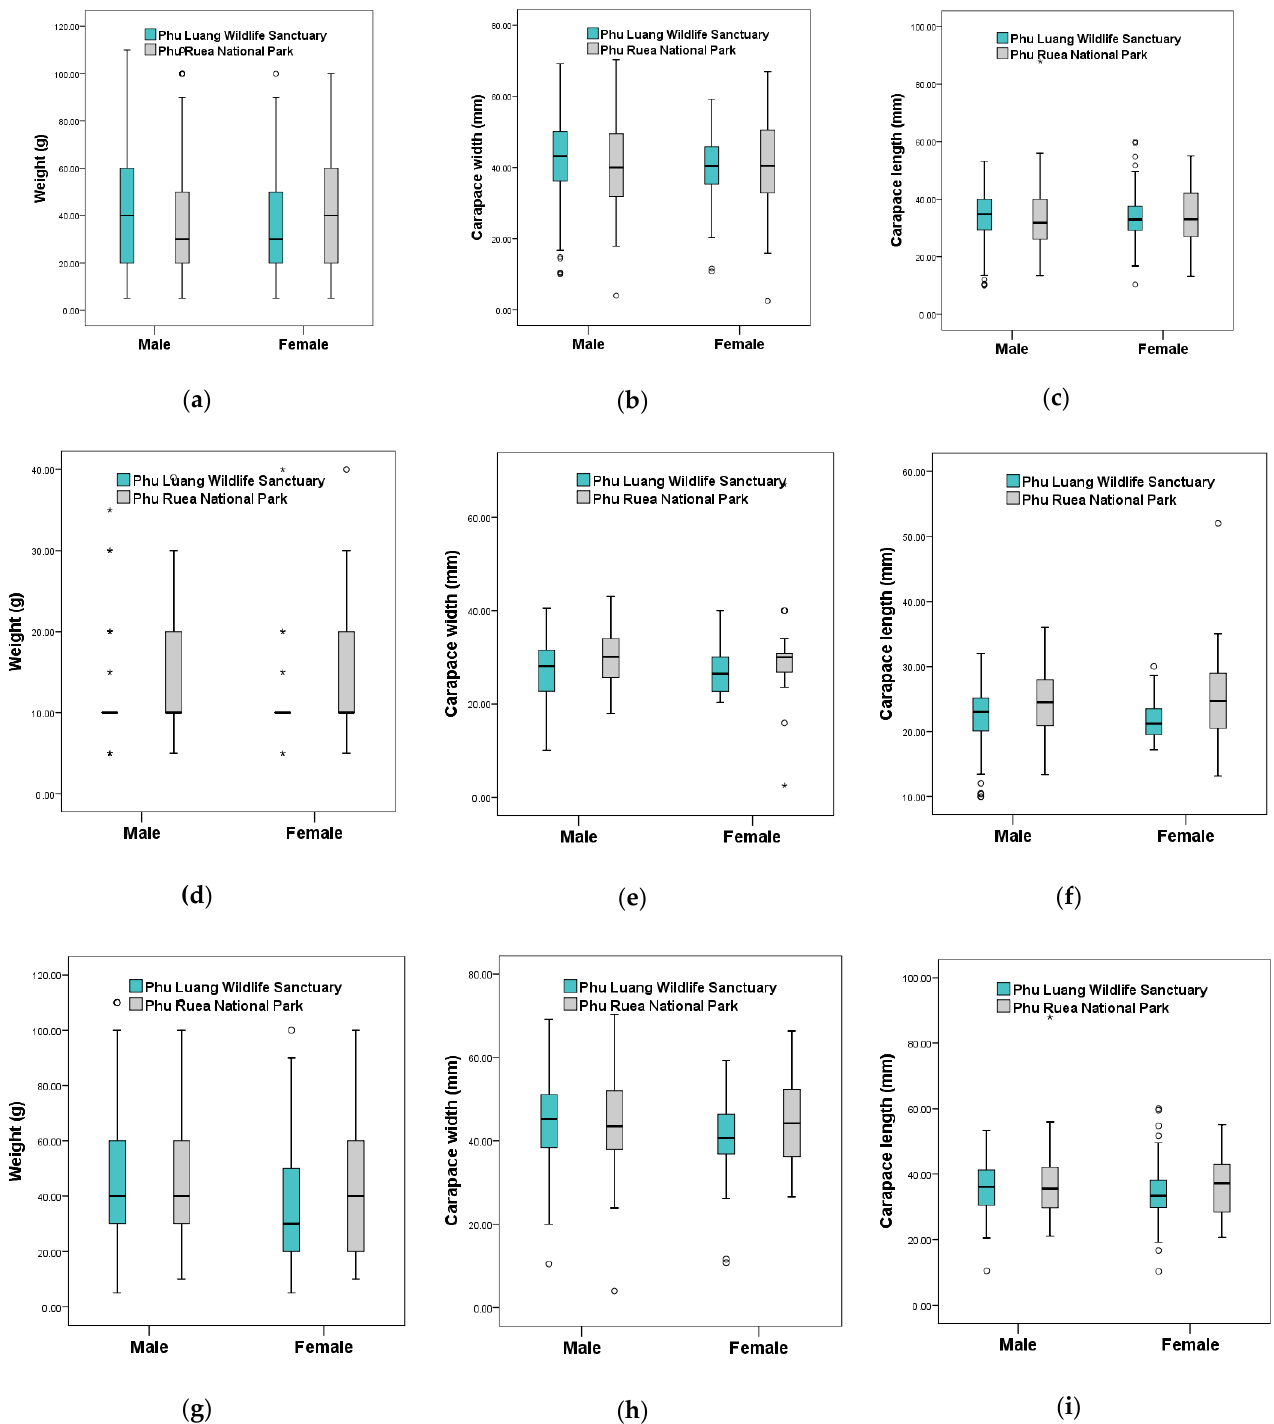
Figure 4. Body size of males and females of I. bhumibol in Phu Ruea National Park and Phu Luang Wildlife Sanctuary: weight ( a ); carapace width ( b ); carapace length ( c ); juvenile weight ( d ); juvenile carapace width ( e ); juvenile carapace length ( f ); adult weight ( g ); adult carapace width ( h ); adult carapace length ( i ); is outlier; * is extreme outlier.